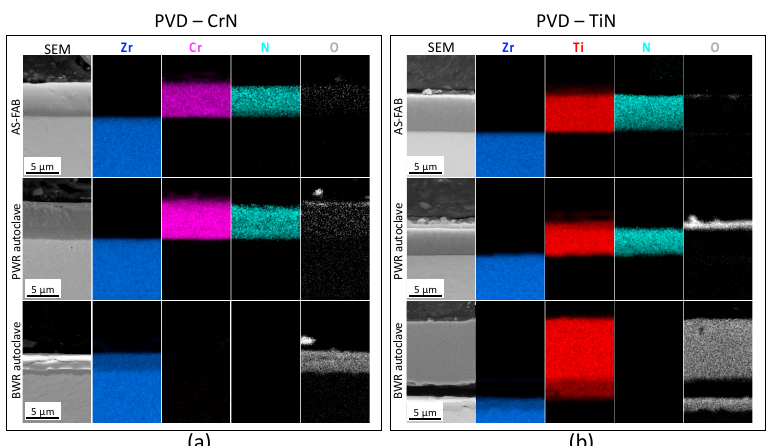
Figure 1. SEM cross-section imaging and EDS mapping. ( a ) CrN coating on HiFi ® cladding: as fabricated, after PWR autoclave exposure, and after BWR autoclave exposure. ( b ) TiN coating on HiFi ® cladding: as fabricated, after PWR autoclave exposure, and after BWR autoclave exposure.